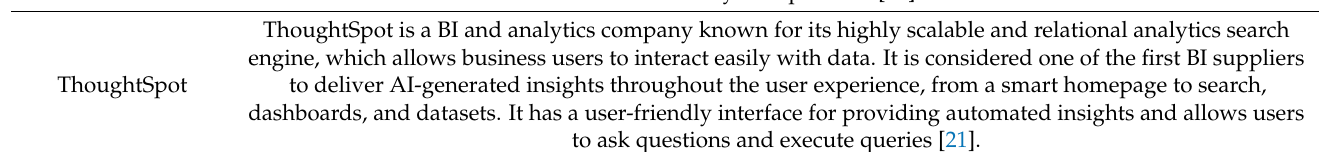
Tableau fully integrates Einstein analytics to leverage AI technologies to examine and analyze data in order to make predictions and recommendations based on those findings. The presence of features such as Ask Data and Explain Data demonstrates that the industry is moving beyond traditional visualization-based solutions. In addition, Tableau uses smart analytics tools such as NLP and NLG to give customers a better data analysis experience